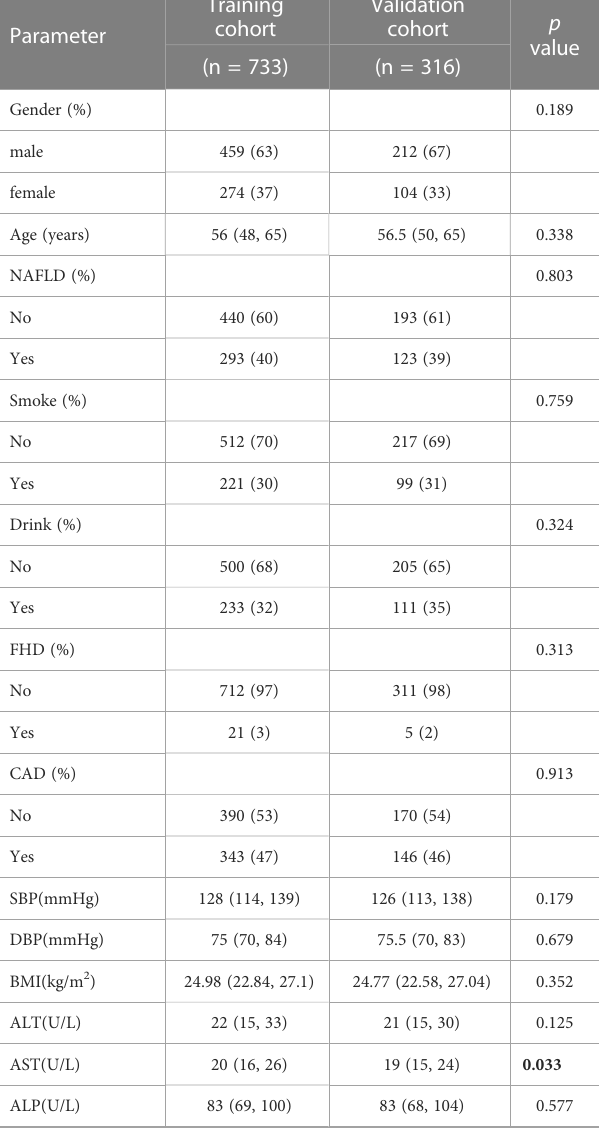
TABLE 1 The Clinical characteristics of patients in the training and validation cohorts.